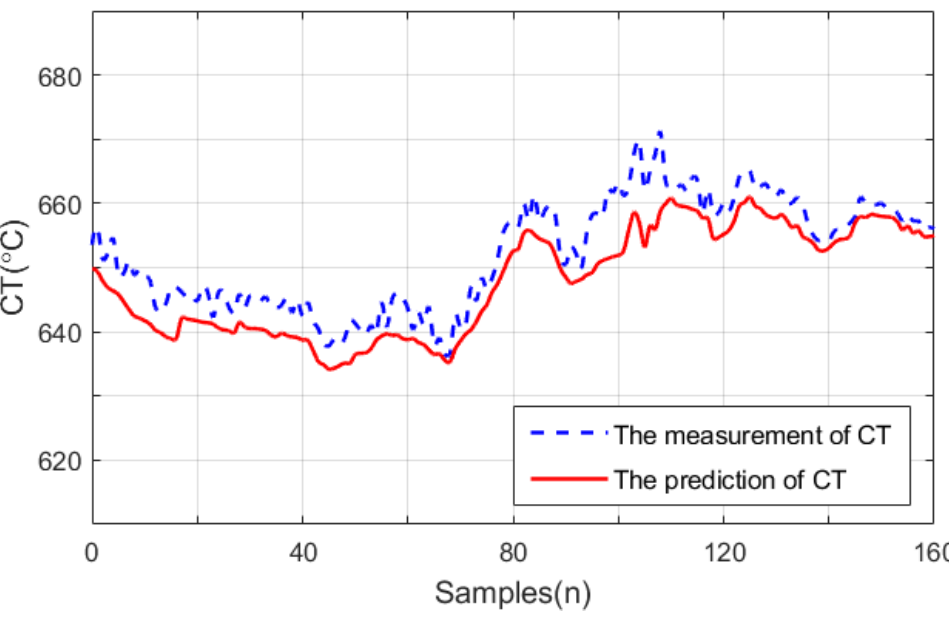
Figure 8. Comparison between the prediction and the measurement of CT with same specifications.